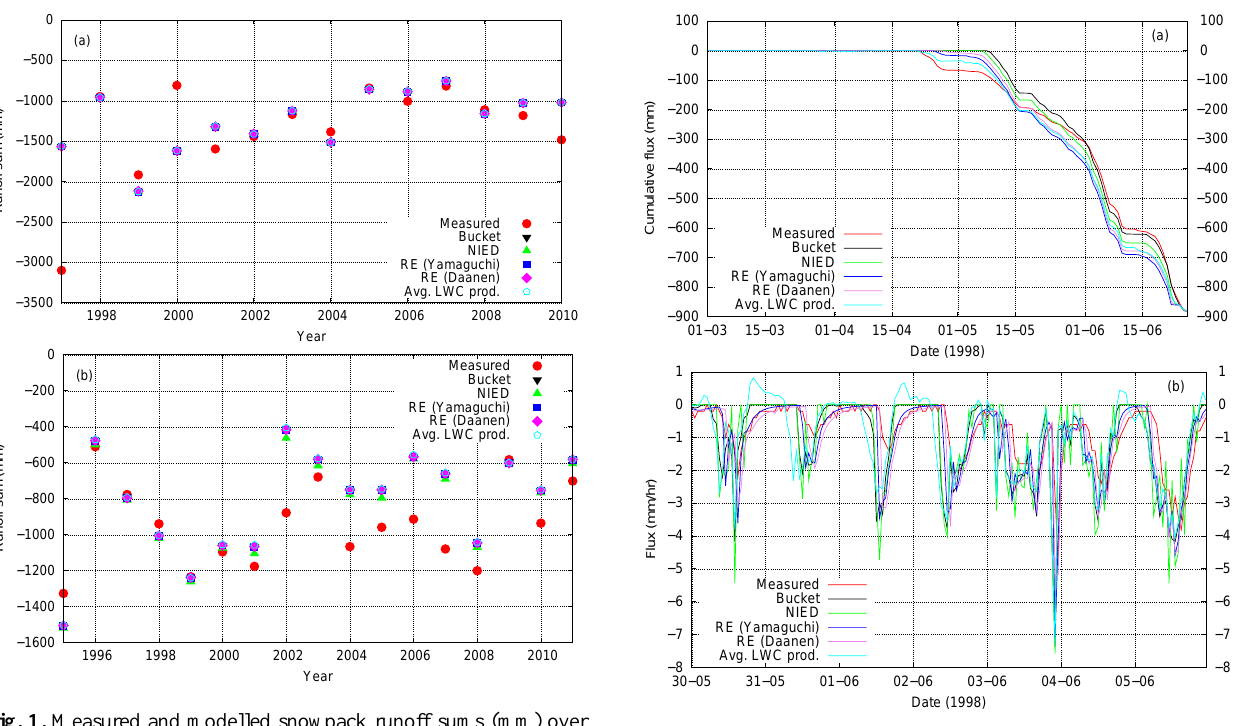
surements and the various water balance schemes for the 1998 melt season (a) and hourly snowpack runoff for the lysimeter measure- ments and the various water balance schemes for one week during the 1998 melt season (b)